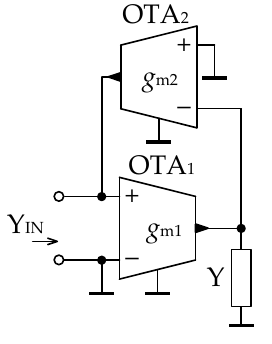
Figure 1. OTA schematic symbol.